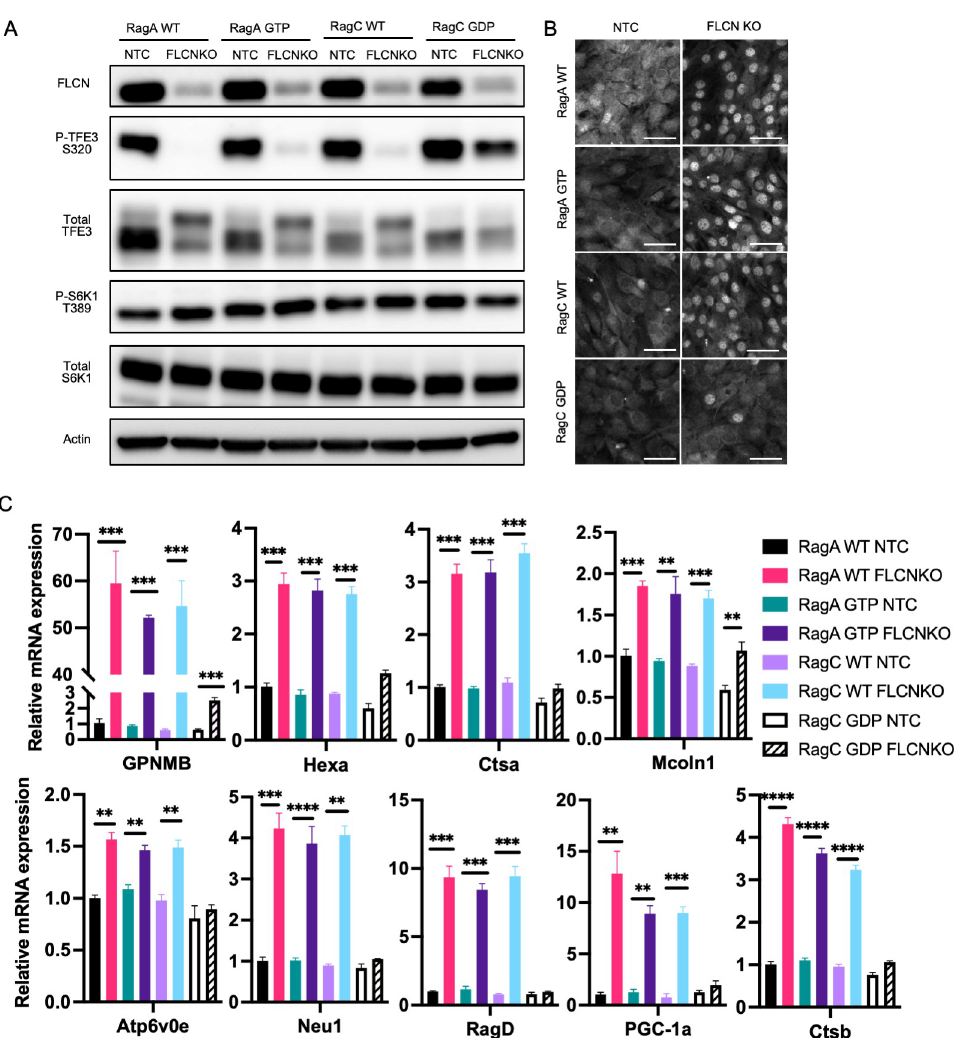
Fig 3. Constitutively active RagC, but not RagA, rescues TFE3 phosphorylation in the absence of FLCN. (A, B) Control C2C12 cells and cells lacking Flcn were transduced with HA-tagged WT or constitutive active RagA (66L) or RagC (75L), followed by immunoblotting for FLCN, TFE3, phospho-TFE3, S6K, and phospho-S6K (A), immunohistochemistry for subcellular localization of TFE3 (B), or quantitative PCR evaluation of expression of the indicated genes (normalized to the average expression of HPRT, TBP, and 36B4 as controls) (C) . Scale bar: 10 μ m, �� p < 0.01, ��� p < 0.001, ���� p < 0.0001 by Student t test. The data underlying all the graphs shown in the figure is included in S1 Data. FLCN, folliculin; KO, knockout; WT, wild type.